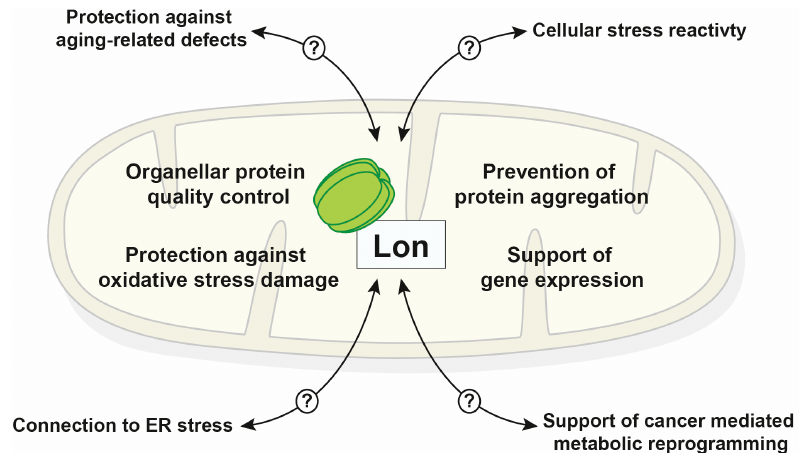
Figure 2. Schematic summary of known Lon functions inside mitochondria and cellular processes that exhibit a direct or indirect involvement of the protease (endoplasmic reticulum